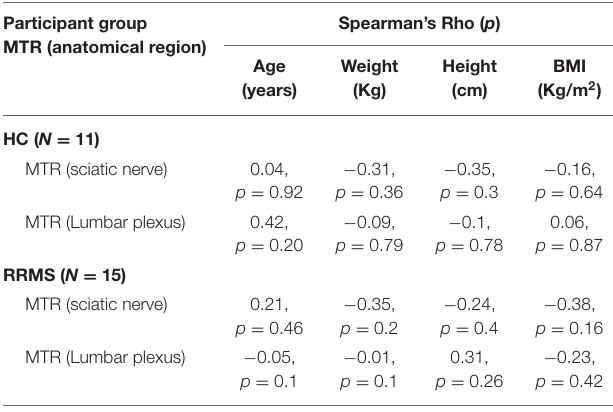
TABLE 2 | Correlations between MTR measures at each anatomical location and demographic characteristics. Participant group MTR (anatomical region)